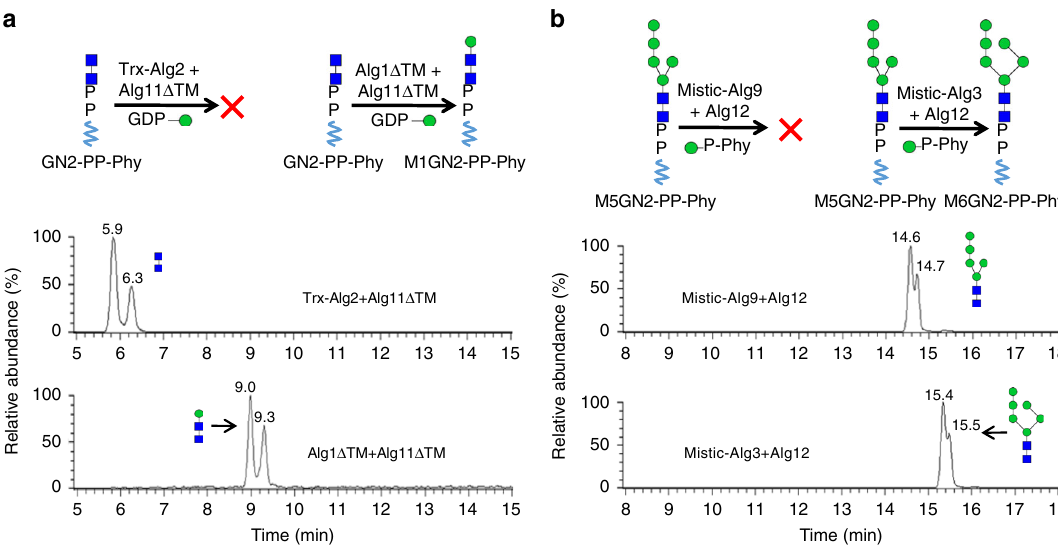
Fig. 5 Substrate speci fi city of Alg MTases. a Substrate speci fi city of Alg1, Alg2, and Alg11. Reactions contained GN2-PP-Phy and GDP-Man and the indicated combination of Alg1 Δ TM, Trx-Alg2, and/or Alg11 Δ TM. Glycan products were analyzed by UPLC – MS. b Substrate speci fi city of Alg3, Alg9, and Alg12. Each reaction contained M5GN2-PP-Phy and Man-P-Phy and the indicated combination of Mistic-Alg3, Mistic-Alg9, and Alg12. Glycan products were analyzed by UPLC – MS. Reaction products are indicated by the arrows, and their deduced structure is depicted